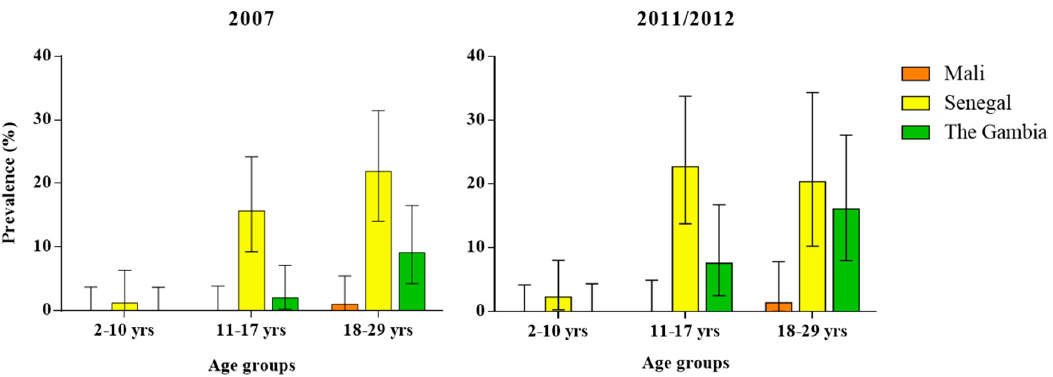
Figure 2. Anti-ZIKV MNT antibody prevalence in Mali, Senegal and The Gambia, by age group: ( left ) in 2007 and ( right ) in 2011 / 2012.